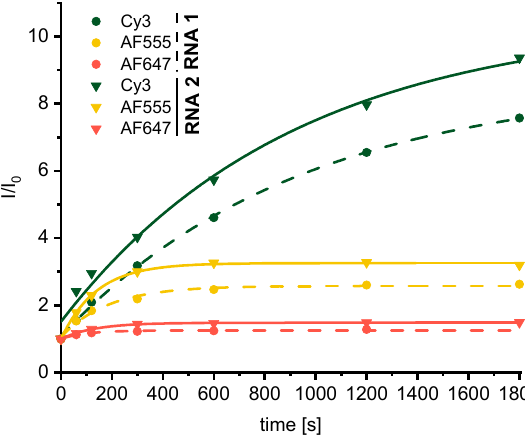
Figure 3. Fluorescence intensity changes during the photoclick modification of RNA1 (2.5 μ M, dashed lines) and RNA2 (2.5 μ M, solid lines) in the presence of Cy3-maleimide, AF555-maleimide and AF647 maleimide (each 3.75 μ M, 1.5 equiv.); irradiation at 300 nm, fluorescence excitation at 358 nm, in 10 mM Na-P i buffer (250 mM NaCl, pH 7). I 0 is the fluorescence intensity before the irradiation.